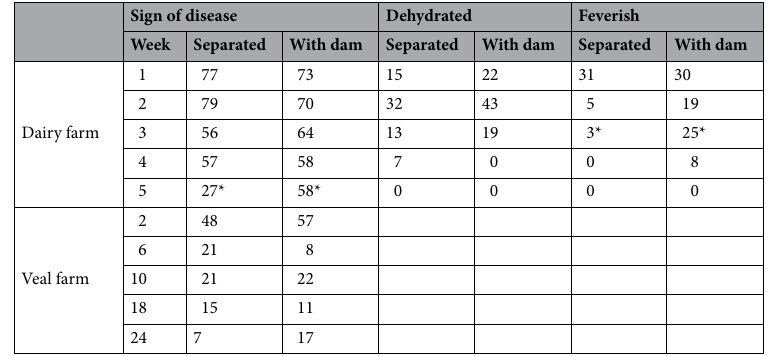
Table 3. Percentage of calves with at least one sign of disease (all health scores are combined into a binary variable, as present/absent), showing signs of dehydration (based on skin elasticity test) or with a fever (≥ 39.5 °C) across weeks on the dairy and veal farms. Significant differences (P ≤ 0.05) are indicated with*.